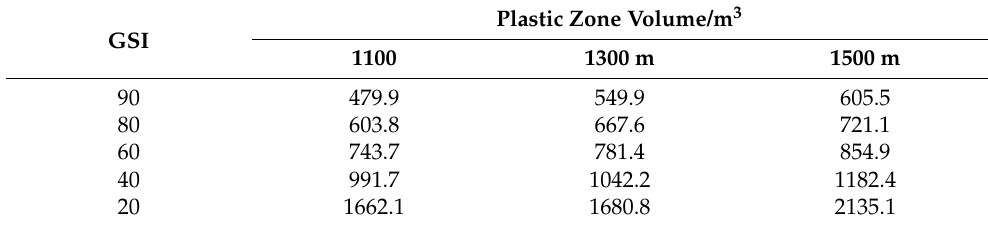
Figure 10. Plastic zone distribution of surrounding rock. Table 6. Plastic zone volume of roadway under different rock mass grades. Table 6. Plastic zone volume of roadway under different rock mass